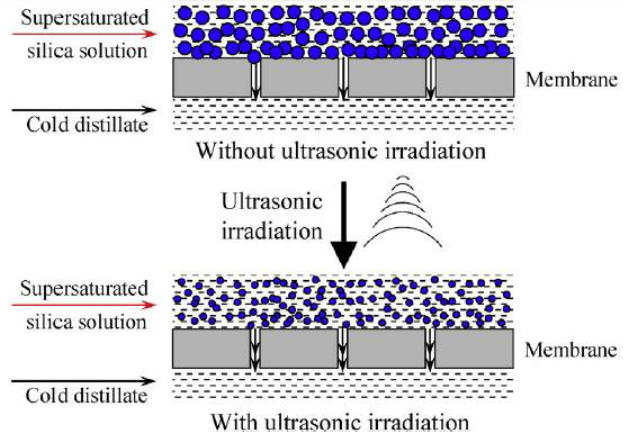
Figure 29. Morphological images of PTFE membrane after silica solution concentration: ( a ) 2000 × ; ( b ) 5000 × [140].